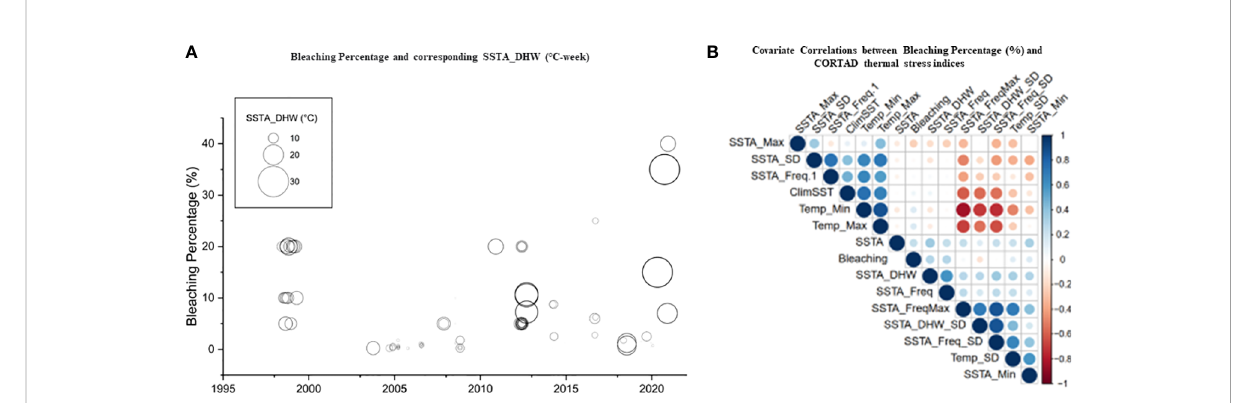
FIGURE 4 Percentageof bleachingfrom in situ observationsandrelationshipswithprecalculatedthermalindicesobtainedfromremotesensedSSTobtainedfrom CORTAD v.6 dataoverthe1998-2020period. (A) RelationshipbetweenDHWsandbleachingpercentagewherethecirclesizeindicatedtheextent of percentagebleaching(indicatingtheincreaseintheseverity of bleachingovertime alongtheRedSea). (B) Correlationplotbetweenprecalculatedthermal indices(CoRTAD)andbleachingpercentage. Nocorrelationwasevidentbetweenindices, unlikepreviously reportedglobal studies.The colourandsizeof thecirclesindicate thestrengthofthe correlationbetweenvariables.